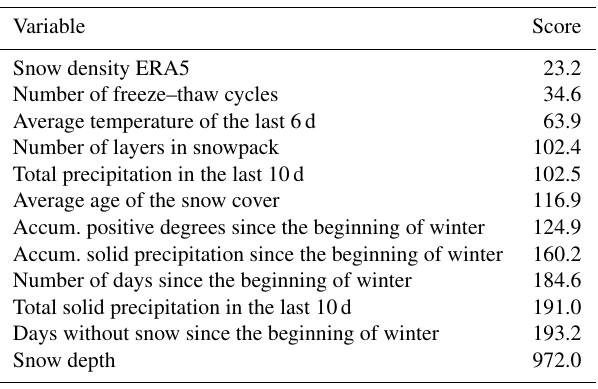
Table 4. Ordered results of the sensitivity analysis from the least to most influential variable. The score is calculated following Sect. 2.4.7. The value of this score is proportional to the importance of a